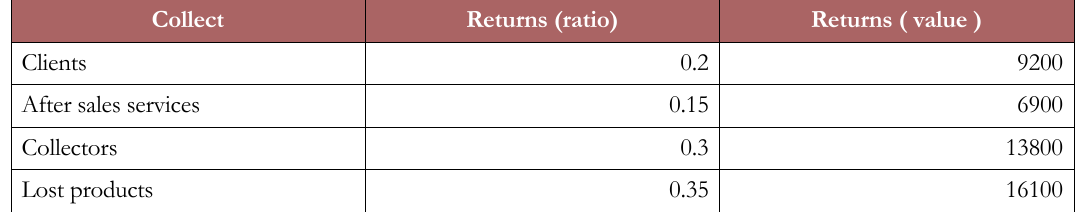
Table 1. Ratio and values of returns depending on the source of returns